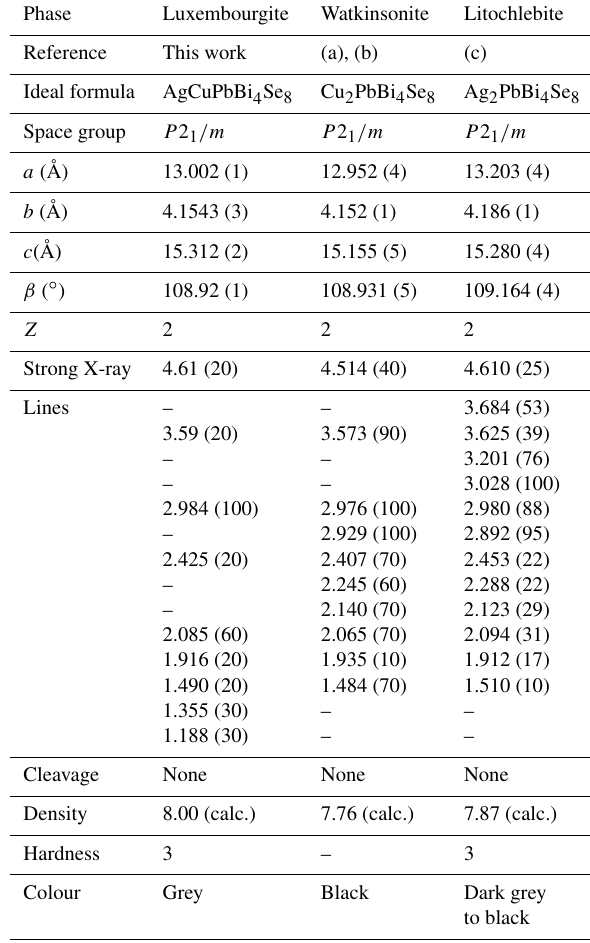
Table 6. Comparison of the physical properties of luxembourgite, watkinsonite, and